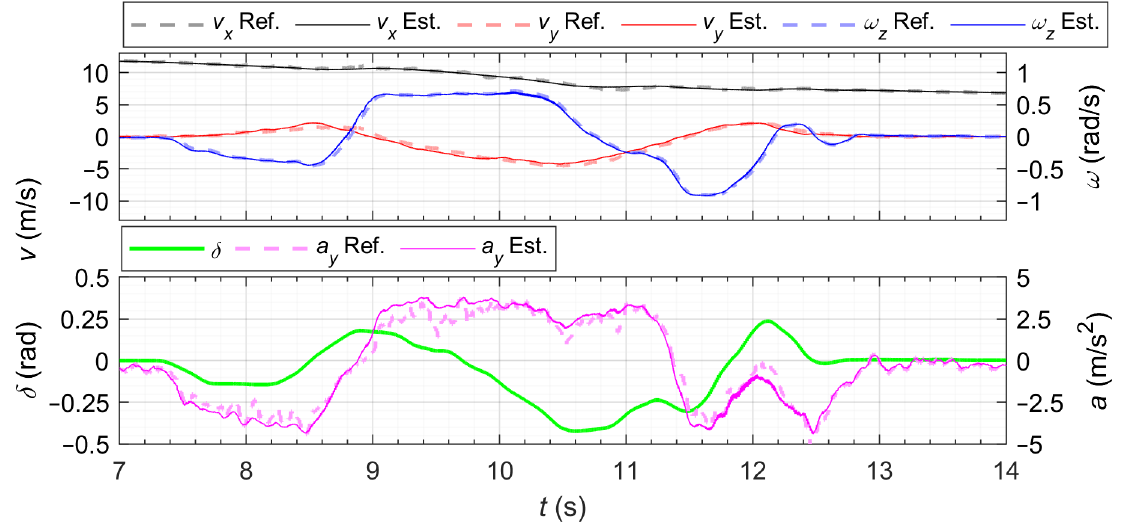
Figure 5. Test data—evasion maneuver on a wet road surface: measured and estimated velocities, yaw rate, lateral acceleration, and steering